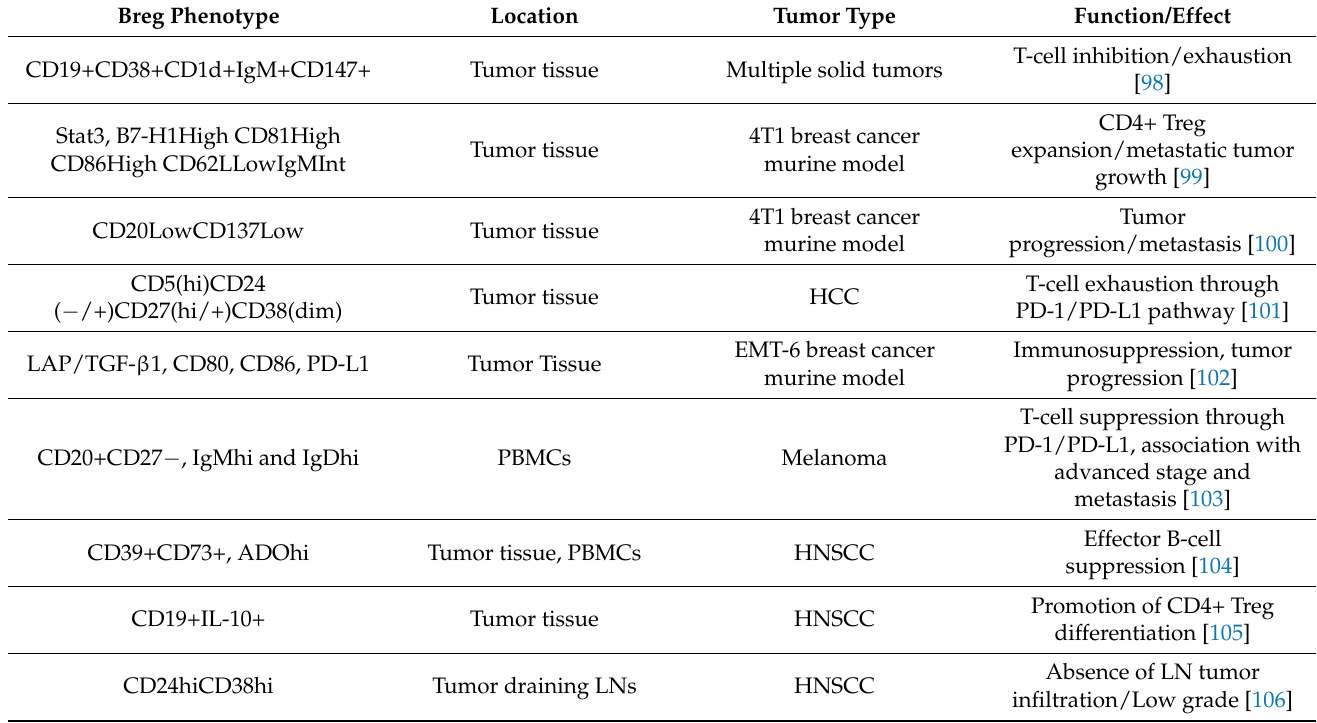
Table 1. Breg phenotypes in